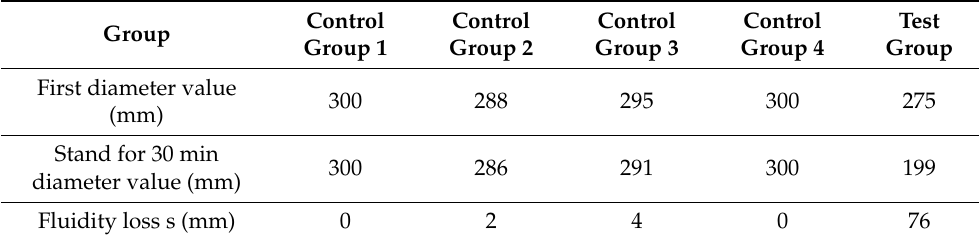
Table 6. Fluidity test results of Embodiment 1.